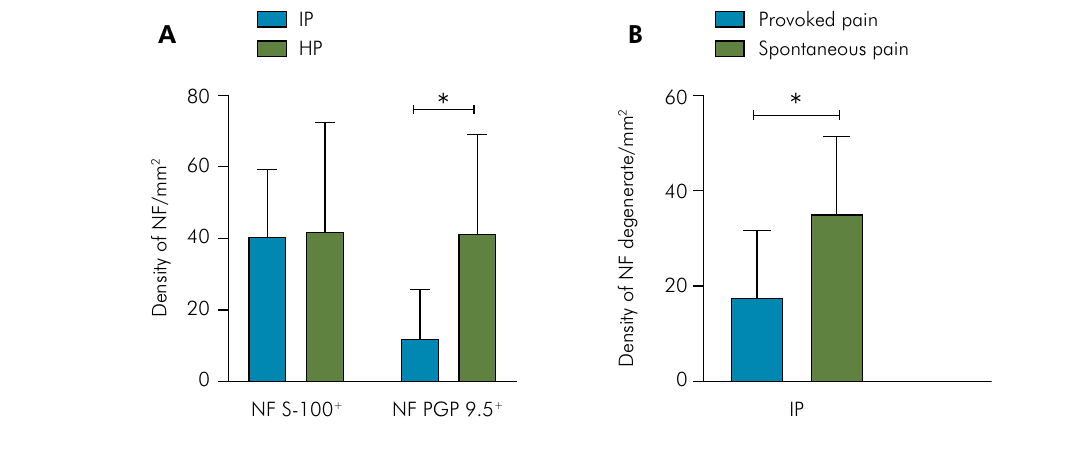
Figure 3. (A) Density of nerve fibers (NF) expressing S-100 + and PGP 9.5 + in irreversible pulpitis (IP) and in healthy pulp (HP) samples. (B) Density of degenerated NF in IP samples with reported information about spontaneous and provoked